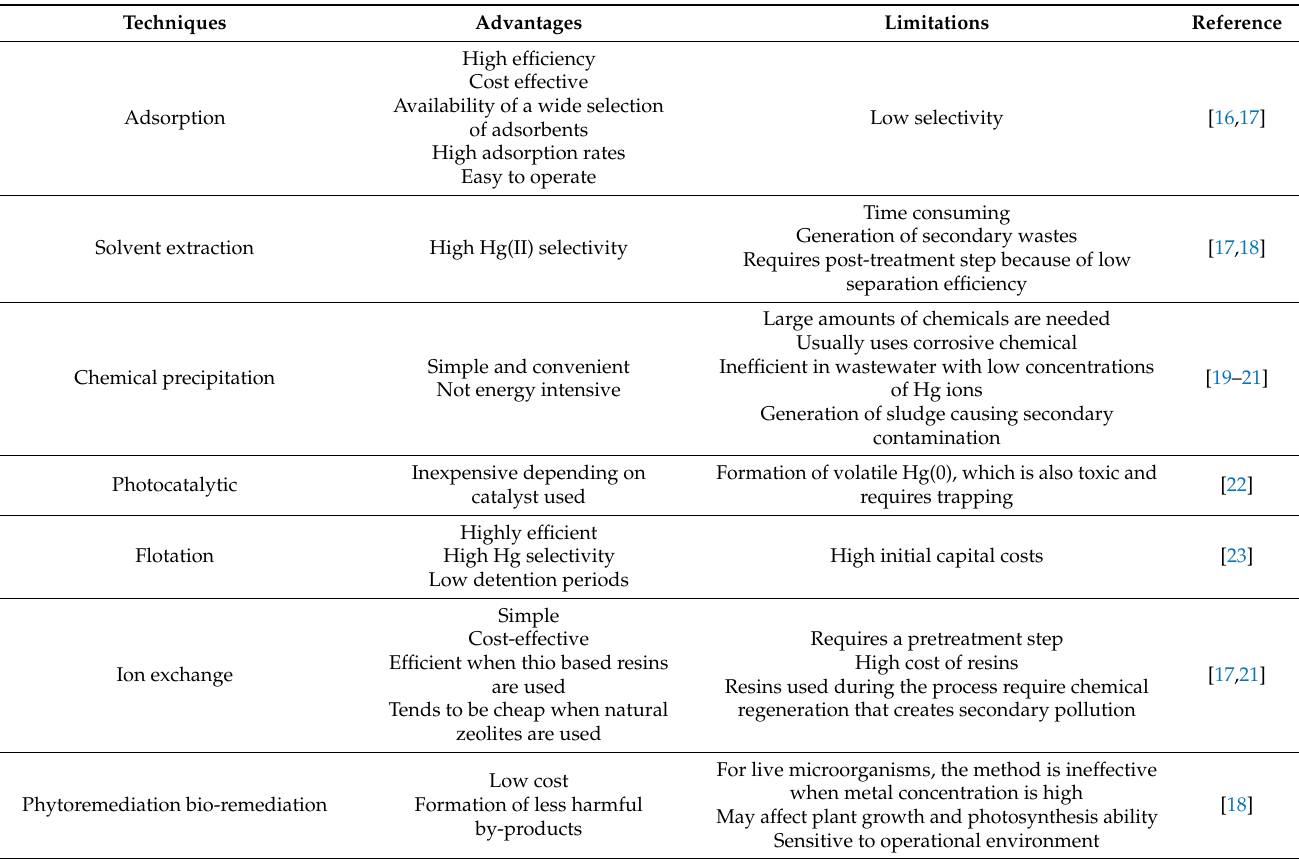
Table 1. Mercury removal techniques with advantages and